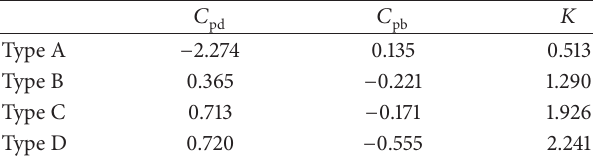
Table 1: Performance parameters of different collection